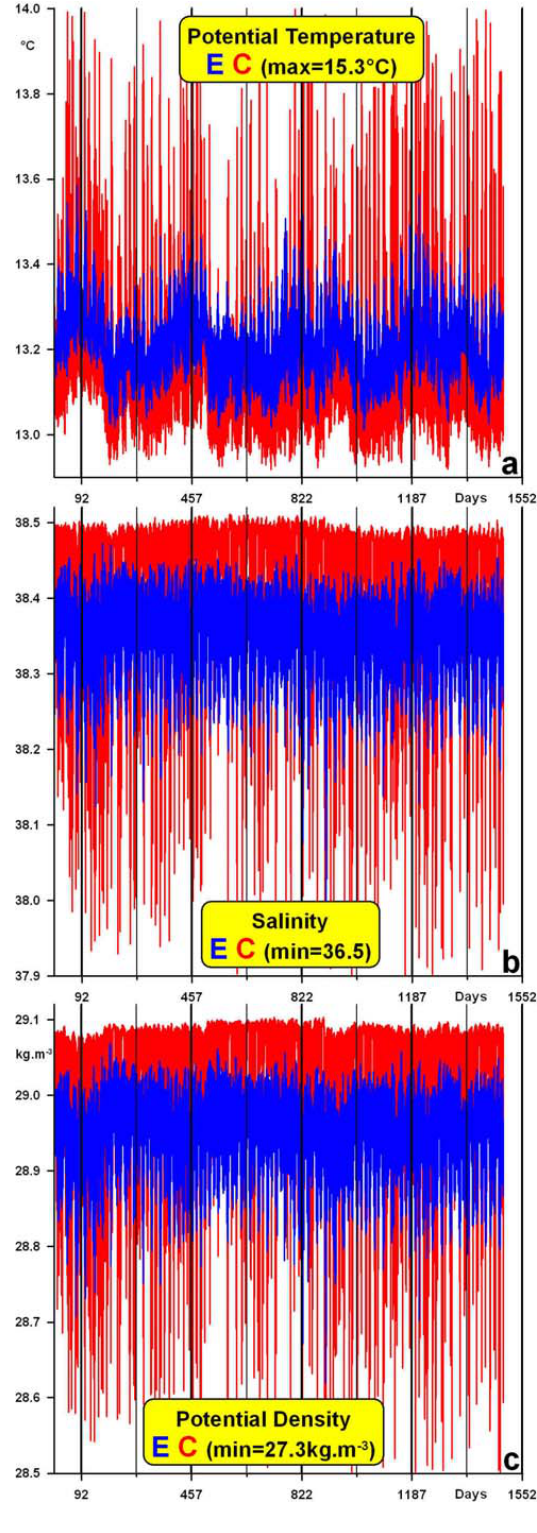
Fig. 2. Original time series of potential temperature (a) , salin- ity (b) and potential density (c) at C (red) and E (blue) over specified